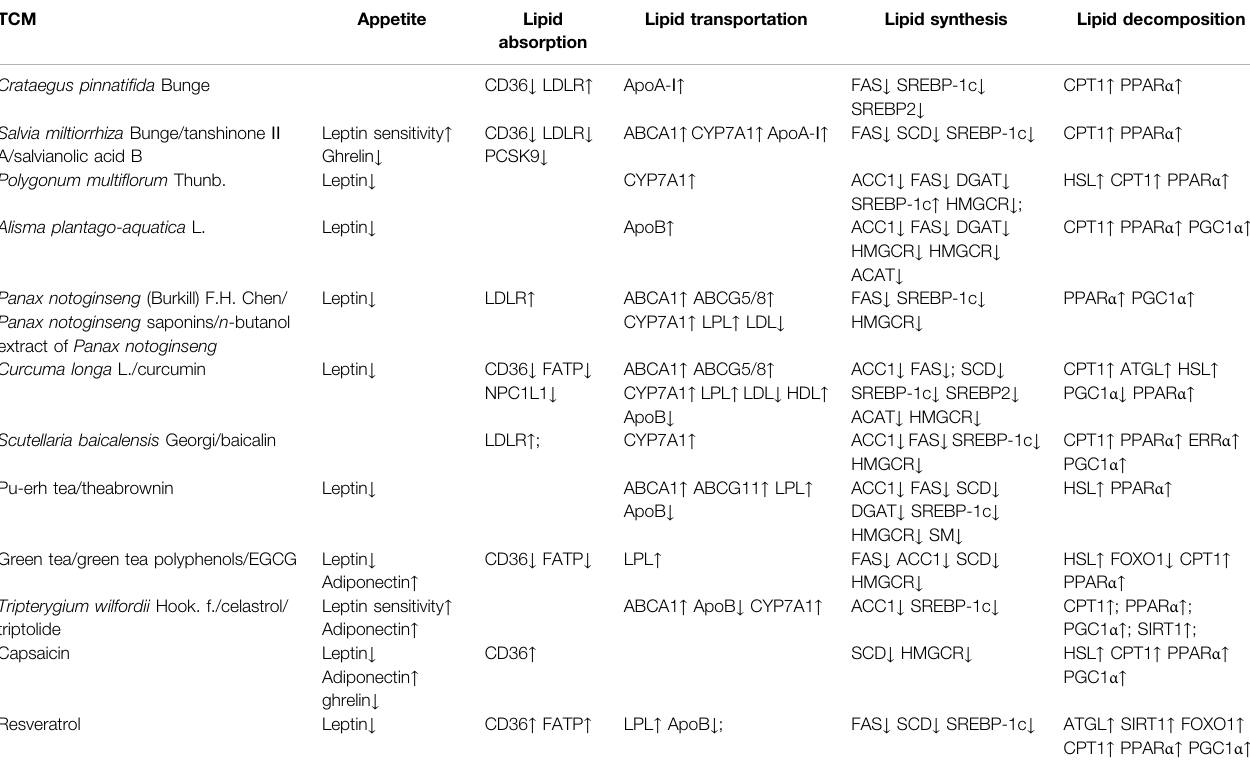
TABLE 2 | A summary of studies demonstrating the effects of TCM on lipid metabolism in animal models and humans.